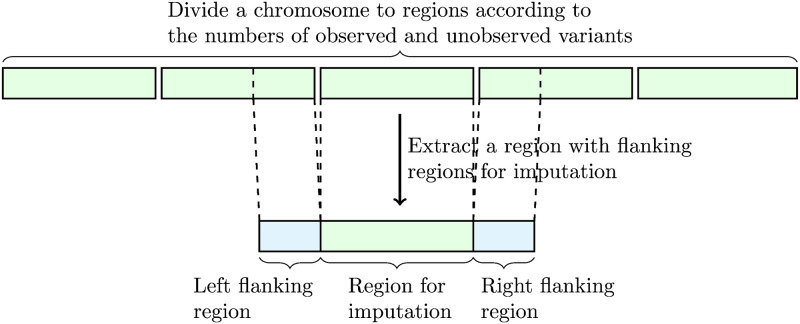
An illustration of division of a chromosome to regions according to the numbers of observed and unobserved variants for imputation.